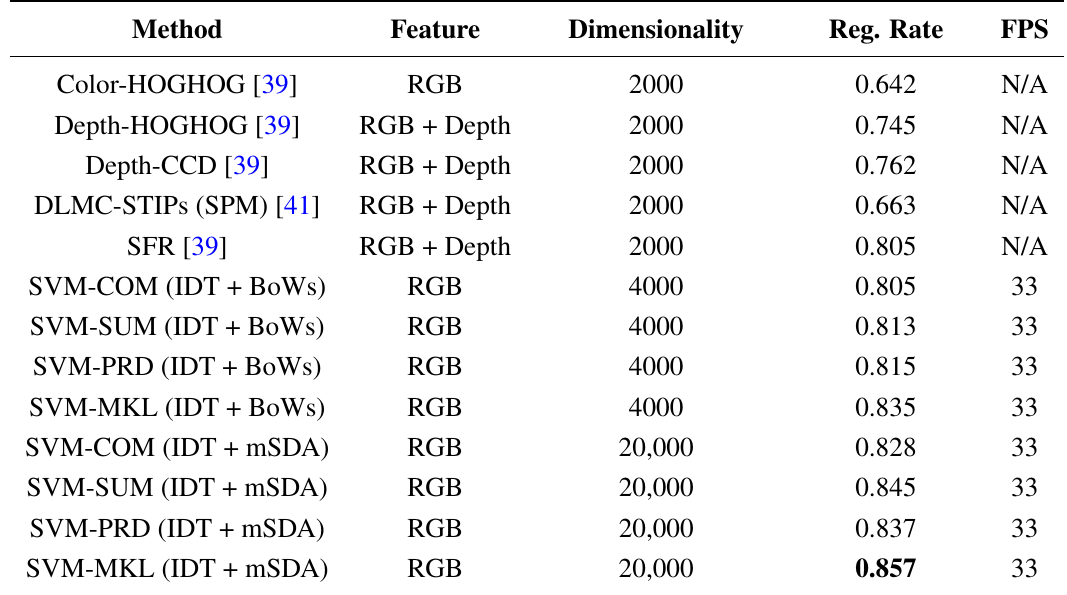
Table 3. Comparison of all the methods in this work using IDT descriptor and BoWs or mSDA on the ACT42 dataset, where the methods with “N/A” in the FPS column are offline systems that are not reported by the original